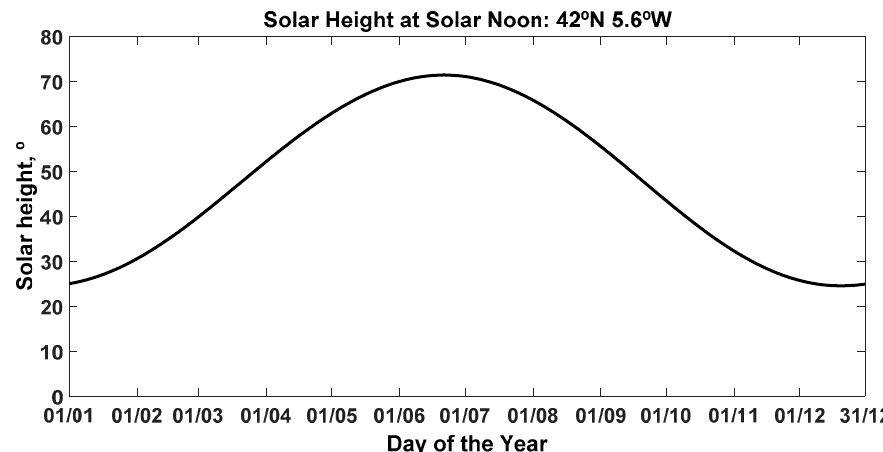
Figure 6. Solar height at solar noon calculated at latitude 42° N and longitude 5.6° W for each day of the year.